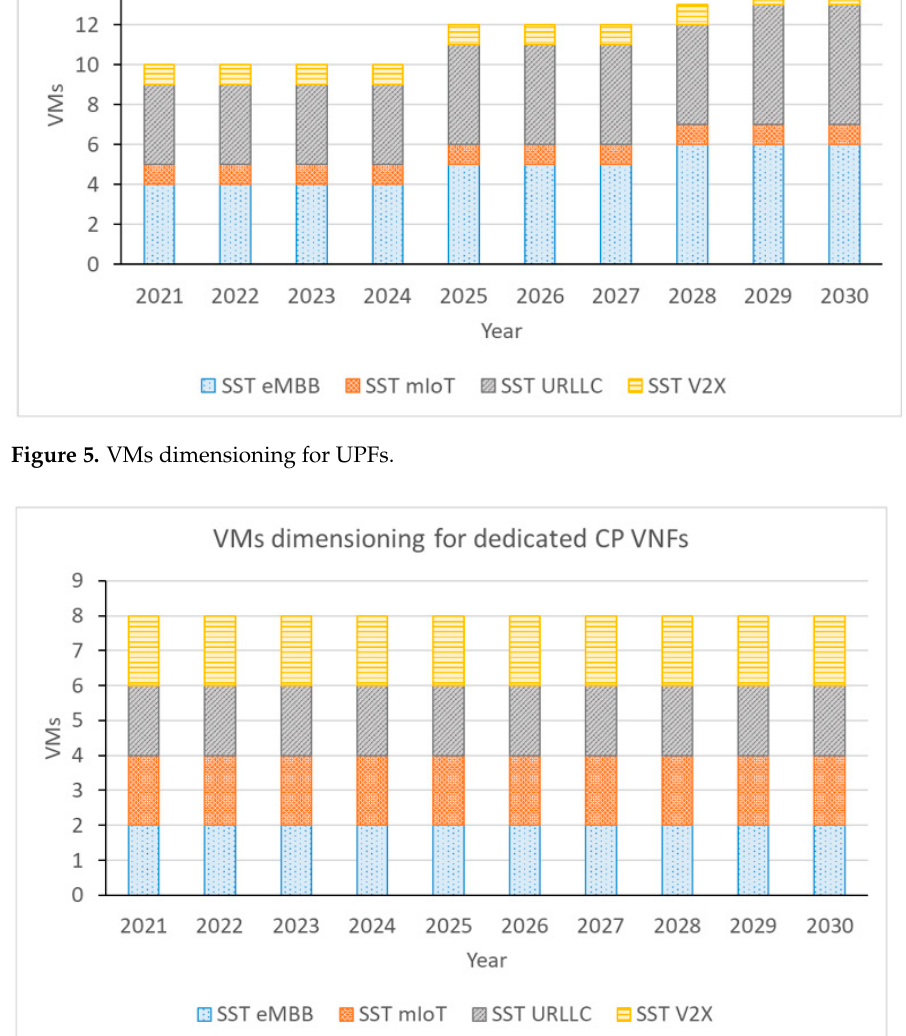
Figure 7. VMs dimensioning for common CP VNFs. 4.3. Cost Calculation and Breakdown Different redundancies can be assumed per slice type to calculate the number of serv- ers required for the VNFs. A redundancy of one means there are no redundant compo- nents and that the minimum number of required components are deployed, while a re- dundancy of two means two components are deployed with one being redundant and so on. In this evaluation, a redundancy of one is assumed for eMBB and mIoT, while two is assumed for URLLC, V2X, and any other VNFs when deployed on common servers for different slice types. When calculating the number of servers based on required VMs, the required num- ber of servers differ for the deployment scenario, as described in the cost model. The same server size and costs are utilized for all deployments for direct comparison. The additional infrastructure components such as required racks are based on the number of servers in each deployment type, and the number of switches is calculated as two per rack. Hence, the total CAPEX (racks, servers, switches), OPEX (maintenance, electricity for servers, switches, and electricity for cooling), and the TCO can be calculated.